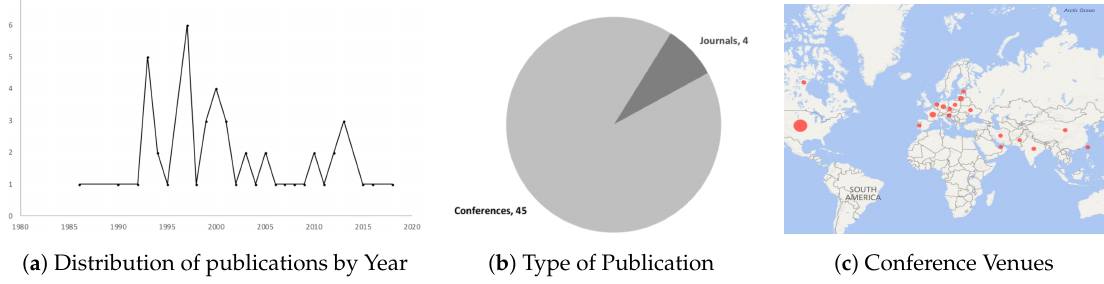
Figure 5. Distribution of publications by year, type, and conference